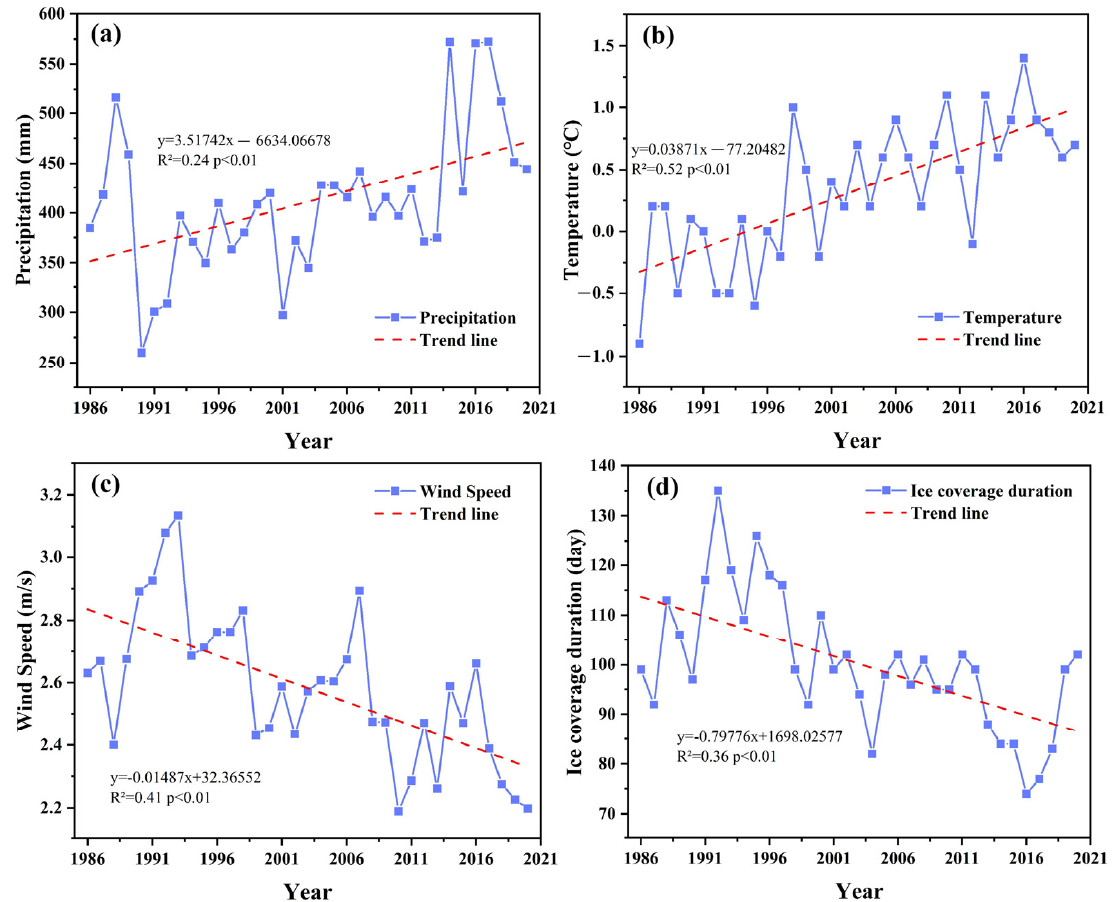
Figure 9. The time series of meteorological and hydrology factors of Lake Qinghai from 1986 to 2020; ( a ) precipitation; ( b ) air temperature; ( c ) wind speed; ( d ) ice cover duration.